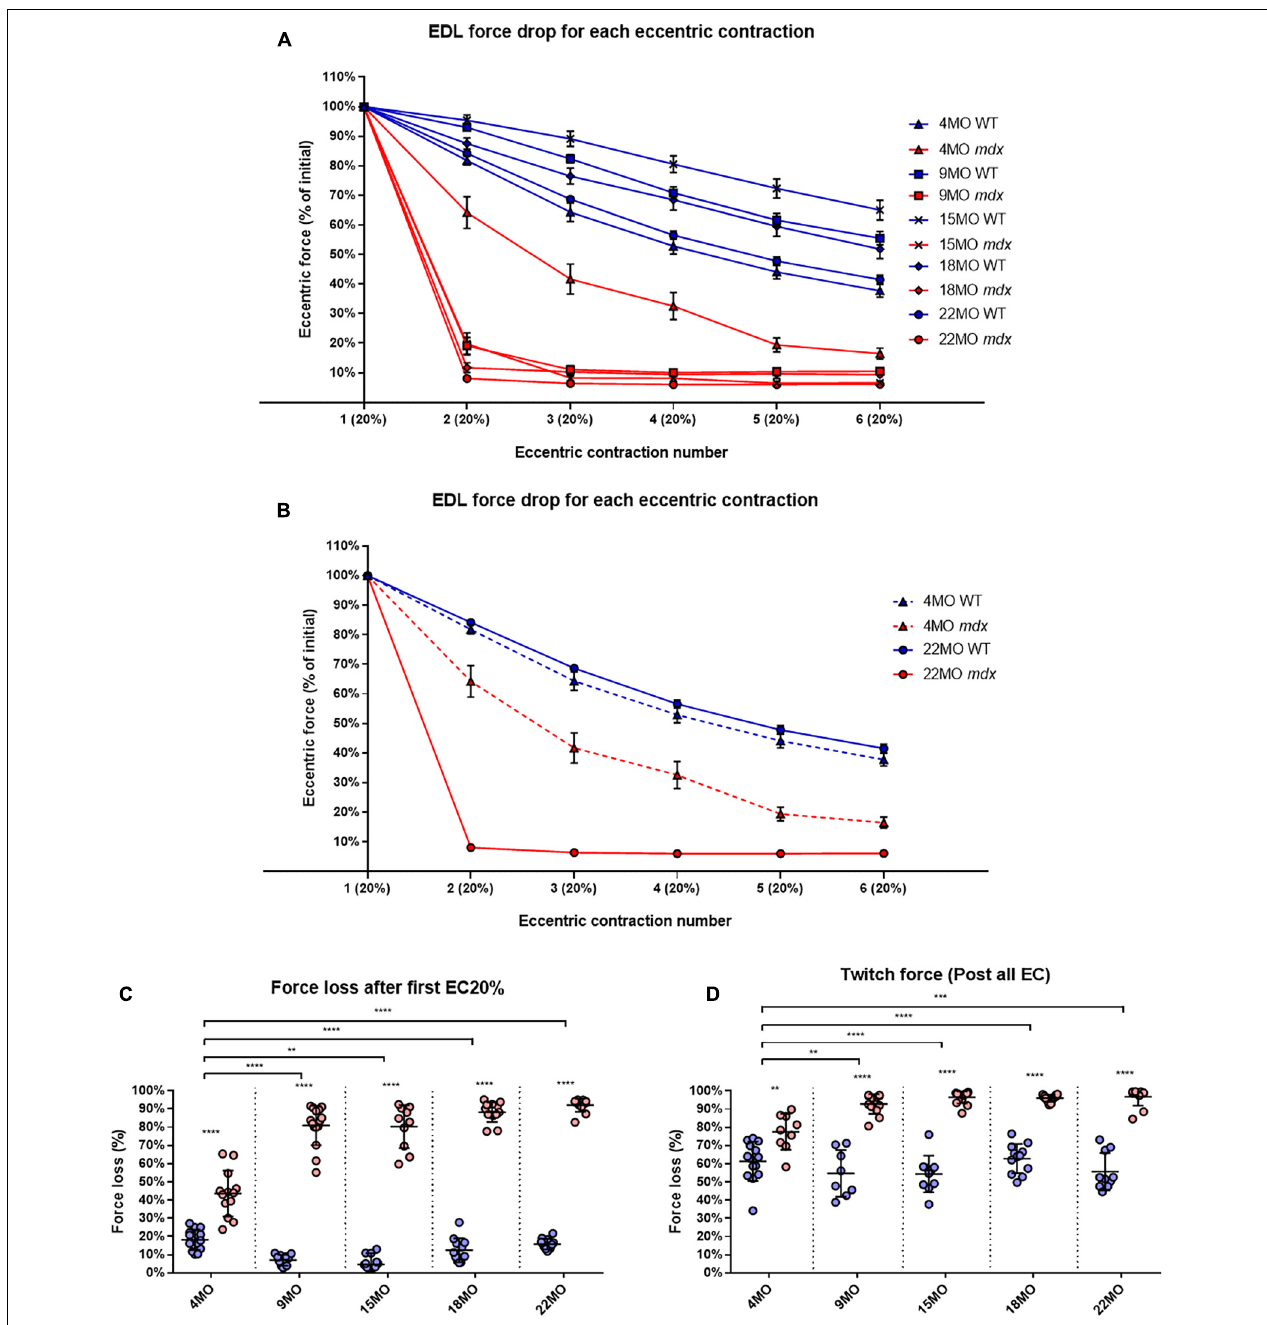
FIGURE 6 | Percentage force loss resulting from a series of six eccentric contractions (ECs) at 20% excursion from L o . Forces were normalized in each group with P max = 100%. (A) XY plot of EDL force loss for mdx mice and littermate controls across all age groups. (B) For clarity 4 month and 22-month-old age groups have been isolated to highlight the differences in eccentric force loss across these contractions. Data shown in these curves are mean ± SD. (C) Interleaved scatterplots of the force loss after the first 20% EC across 4-month ( n = 14 control; n = 13 mdx ), 9-month ( n = 11 control; n = 15 mdx ), 15-month ( n = 12 control; n = 10 mdx ), 18-month ( n = 12 control; n = 13 mdx ), and 22-month ( n = 12 control; n = 12 mdx ) age groups (Note: these numbers apply to A–C ). (D) Interleaved scatterplots of the twitch force loss after all six EC across 4-month ( n = 14 control; n = 9 mdx ), 9-month ( n = 11 control; n = 16 mdx ), 15-month ( n = 14 control; n = 14 mdx ), 18-month ( n = 12 control; n = 13 mdx ), and 22-month ( n = 10 control; n = 12 mdx ) age groups. For interleaved scatterplots in (C,D) , the horizontal line indicates the mean value ± SD. Statistical differences between age groups are displayed above the graph, statistical differences displayed within graphs are differences between genotypes assessed by two-way ANOVA, post hoc analysis using Sidak’s multiple comparisons test. **** P < 0.0001, ***0.0001 < P < 0.001, and **0.001 < P <